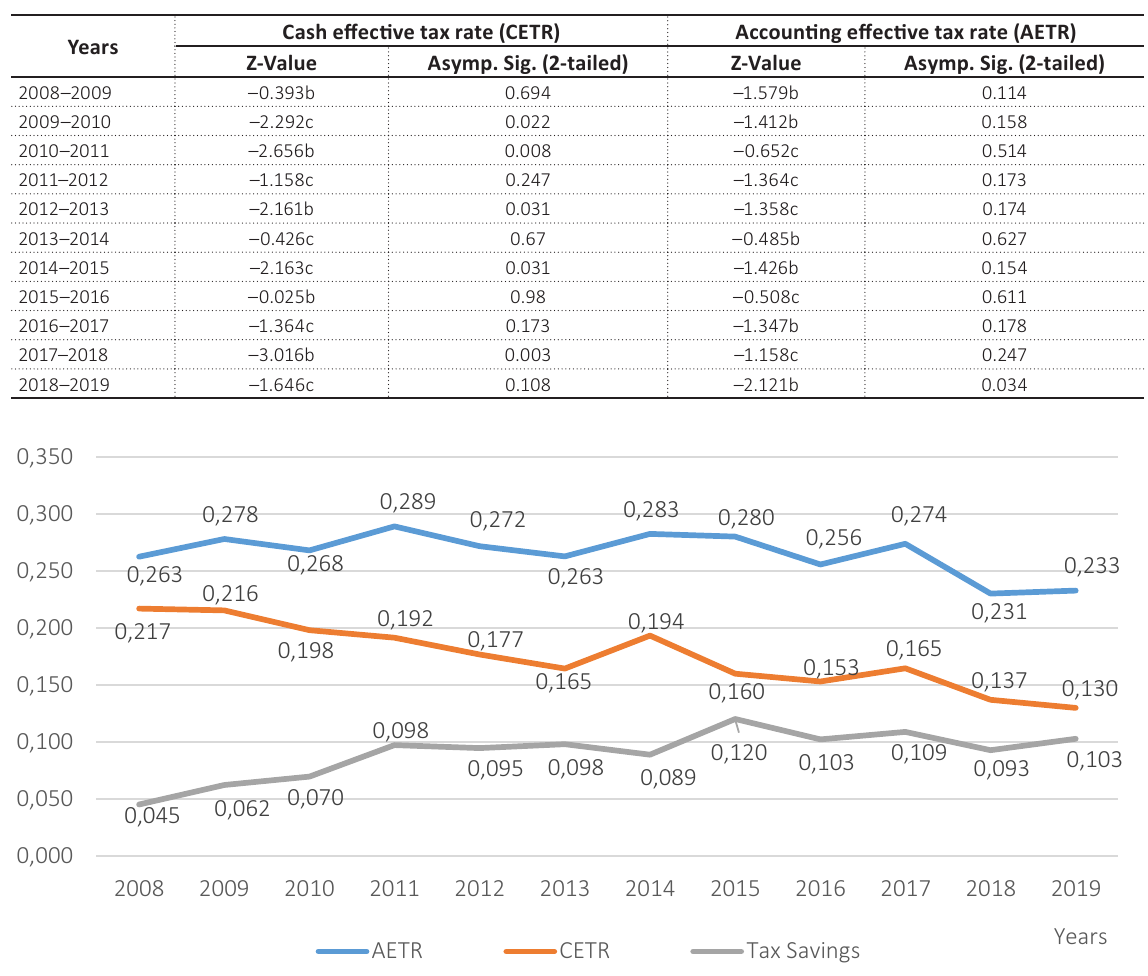
Figure 1. Tax planning trend (2008–2019)